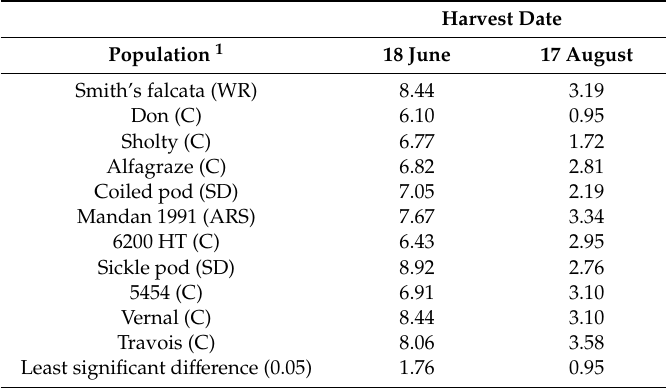
Table 4. Dry matter forage production (Mg ha − 1 ) of eight cultivars and three experimental populations of alfalfa harvested on 18 June and 17 August 2009 at Brookings, South